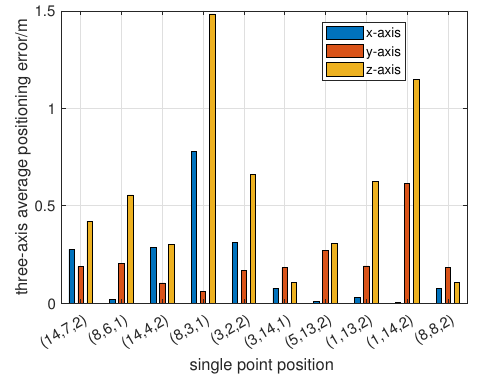
Figure 10. Static single-point three-axis average positioning error.